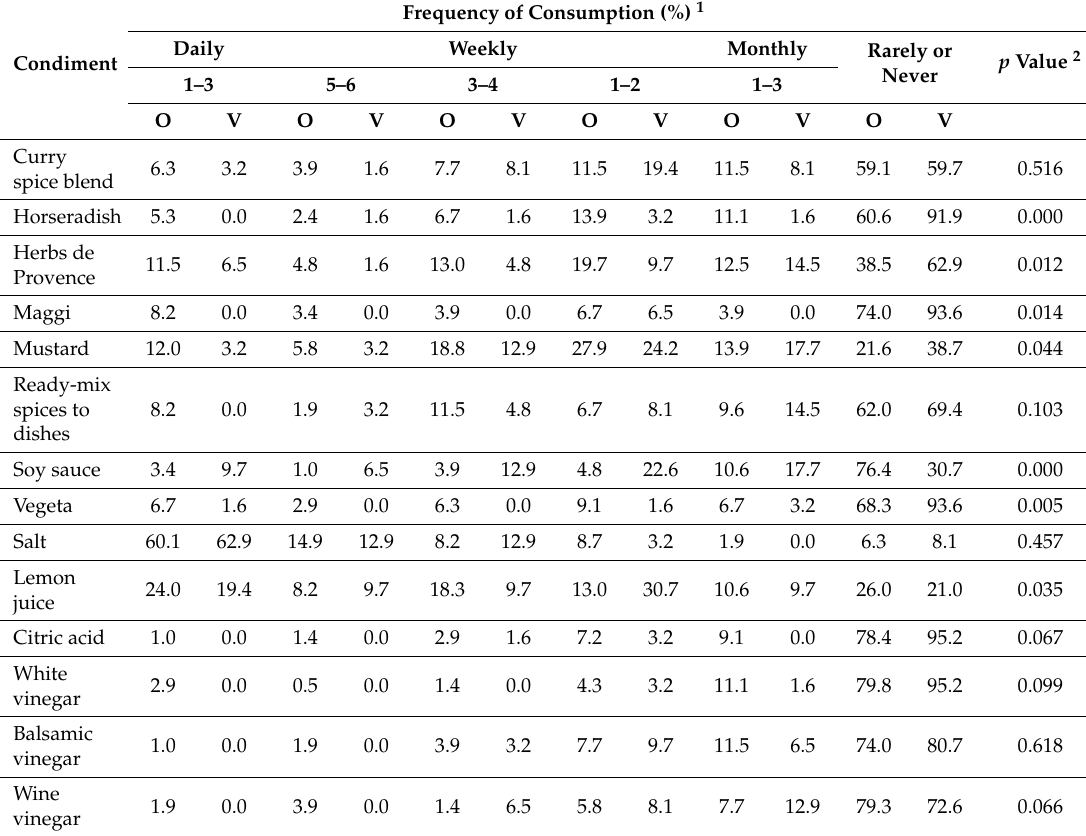
Table 6. Frequency of consumption of seasoning blends and other spices among adult omnivores and